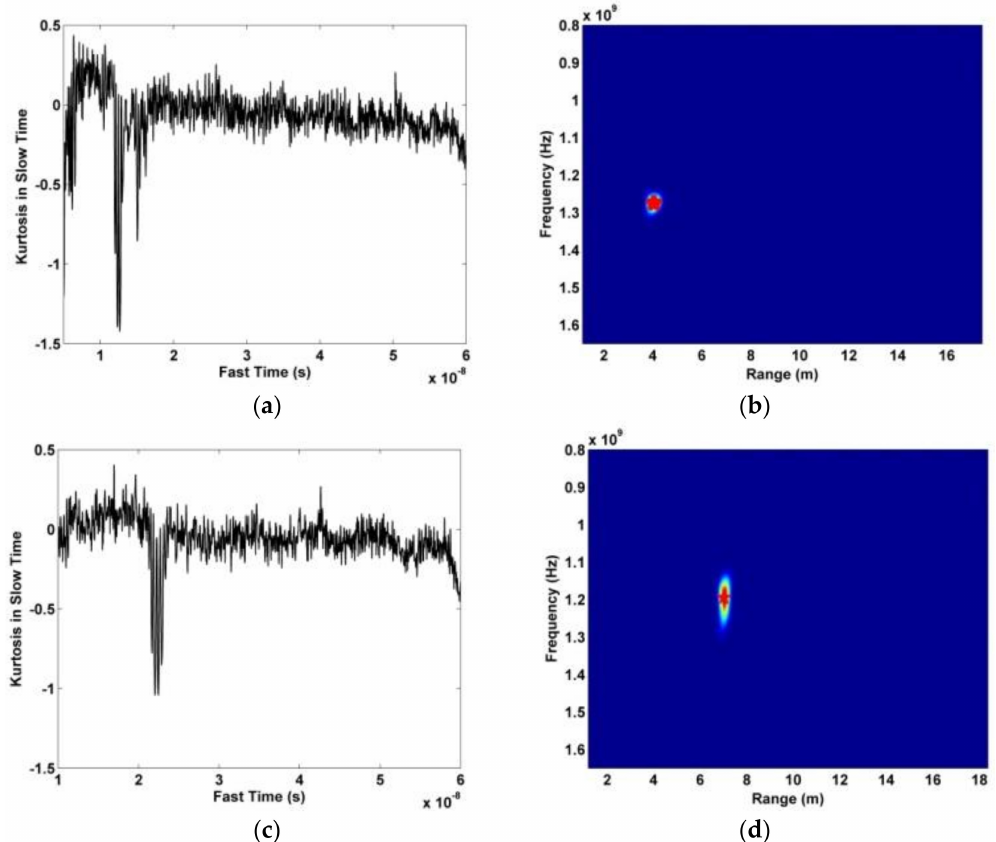
Figure 21. Results for the actuator experiment, ( a ) kurtosis distribution at 400 cm, ( b ) range estimation at 400 cm, ( c ) kurtosis distribution at 700 cm, and ( d ) range estimation at 700 cm.